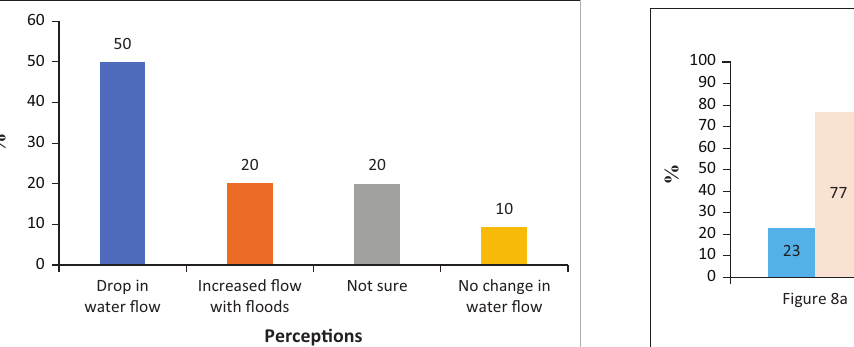
FIGURE 7: Observed changes in water flow patterns at Victoria Falls ( n = 77).